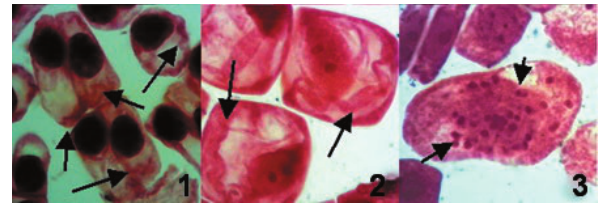
Figure 5. Various changes in the root meristematic cells of A. cepa. 1-2) cells with membrane damage; 3) an apoptotic